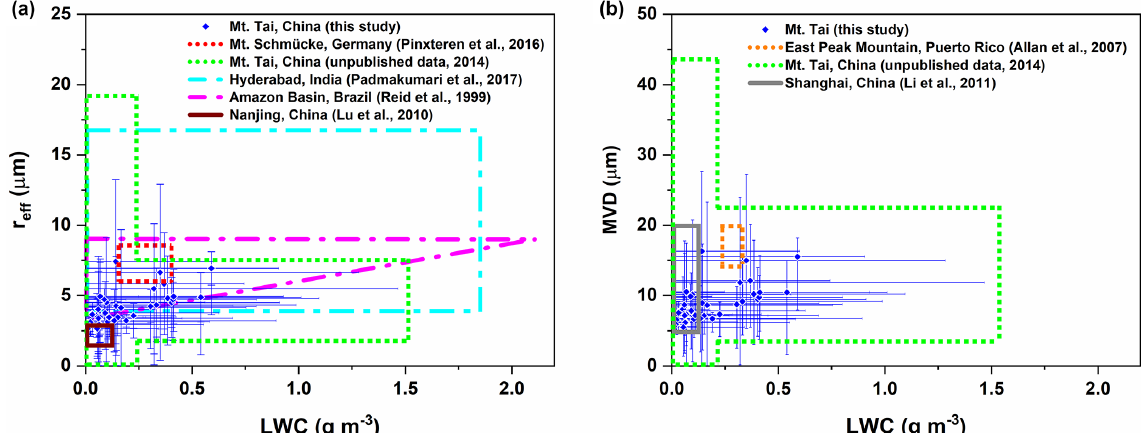
Figure 1. (a) Plots of effective radius ( r eff ) and (b) medium volume diameter (MVD) against liquid water content (LWC) for clouds and fog from the literature. The dotted, dot-dashed and solid lines represent orographic clouds, convective clouds and city fog, respectively. The areas represent the range of data obtained from the corresponding observations. The blue diamonds with error bars represent the average LWC and r eff (or MVD) of 40 cloud events observed at Mt. Tai in this study with corresponding